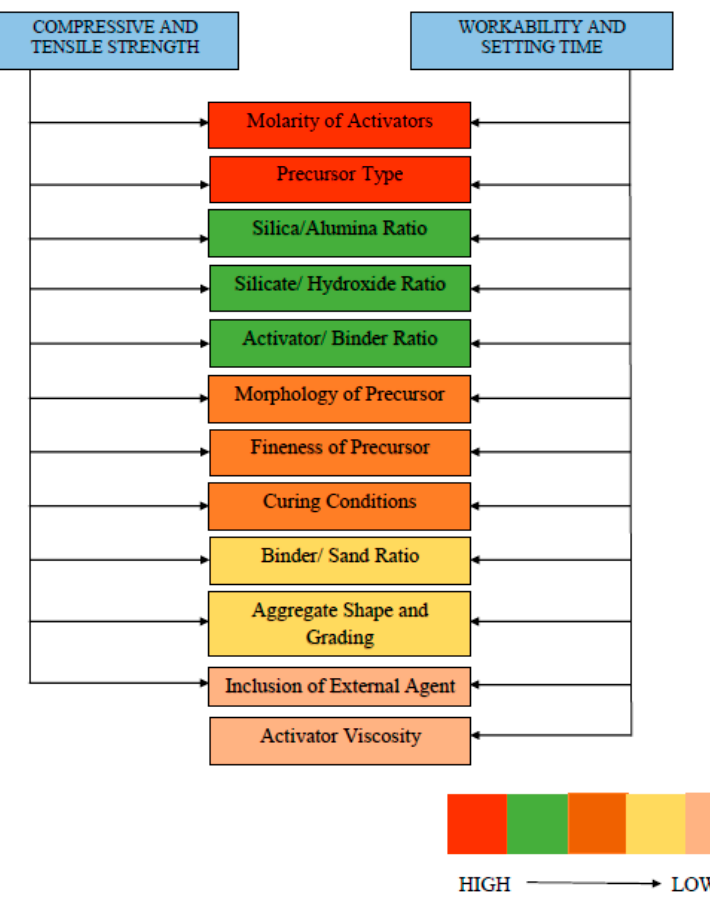
Figure 21. Contributing factors to strength and workability of GPC.